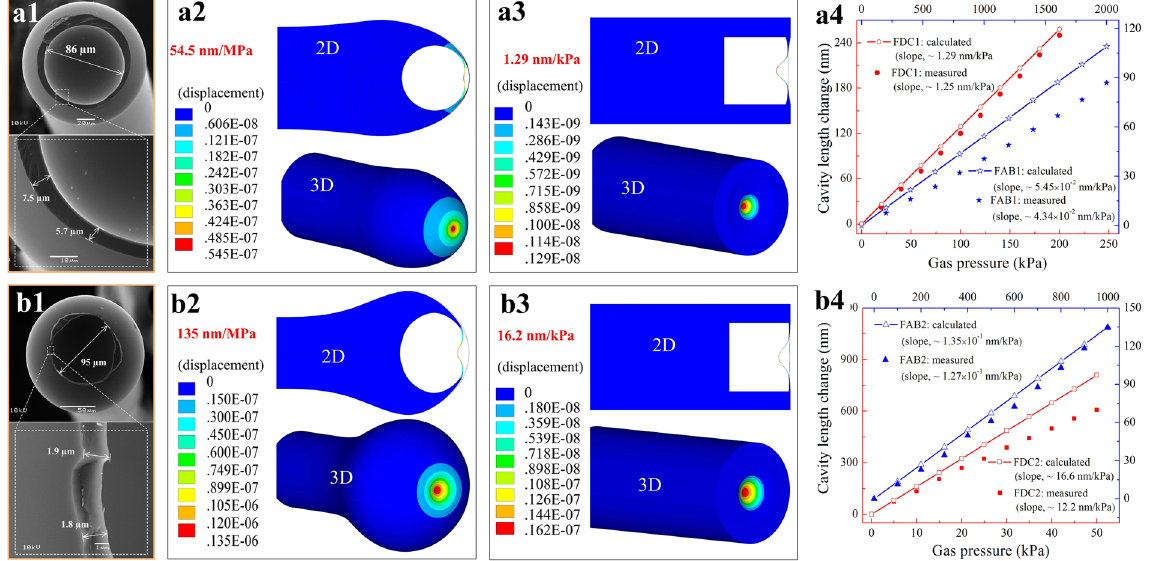
Figure 7. The results of numerical simulation for the cavity length change of two types of specimens employing an FAB or an FDC under an applied pressure. SEM images in ( a1 , b1 ) present the edges of FAB specimens FAB1 and FAB2 exposed by cutting, where the measured dimensions are used for approximating the geometric parameters of the FDC models employed for specimens FDC1 and FDC2, respectively. Simulated deformation contours under an applied gas pressure are presented in ( a2 , a3,b2 , b3 ), where the red areas represent regions of the sensing diaphragm with the largest deformation. ( a4,b4 ) The calculated and measured cavity length changes of the four specimens, FAB1, FDC1, FAB2, and FDC2, versus the applied gas pressure, where the calculated sensitivity are 54.5 × 10 − 2 ( ), 1.29